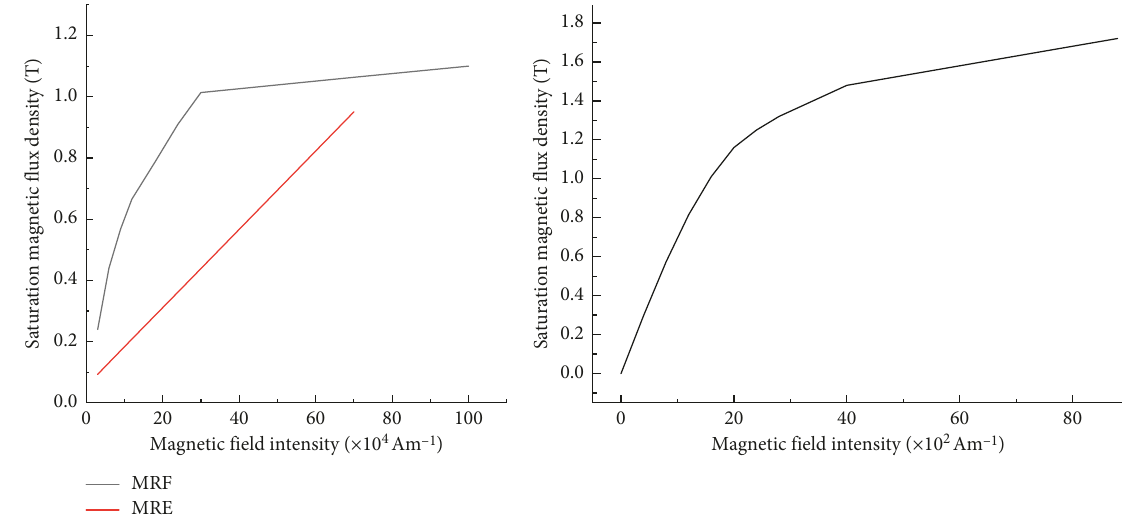
Figure 7: Magnetic characteristic curve of MR material and steel.